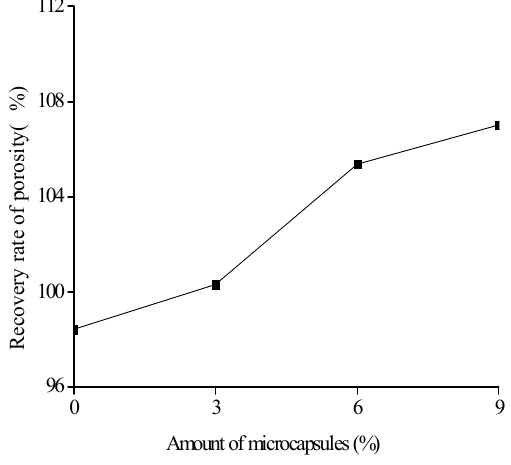
Figure 20. Healing rate (Equation (9): η AVE ) of average pore diameter with amount of microcapsules.